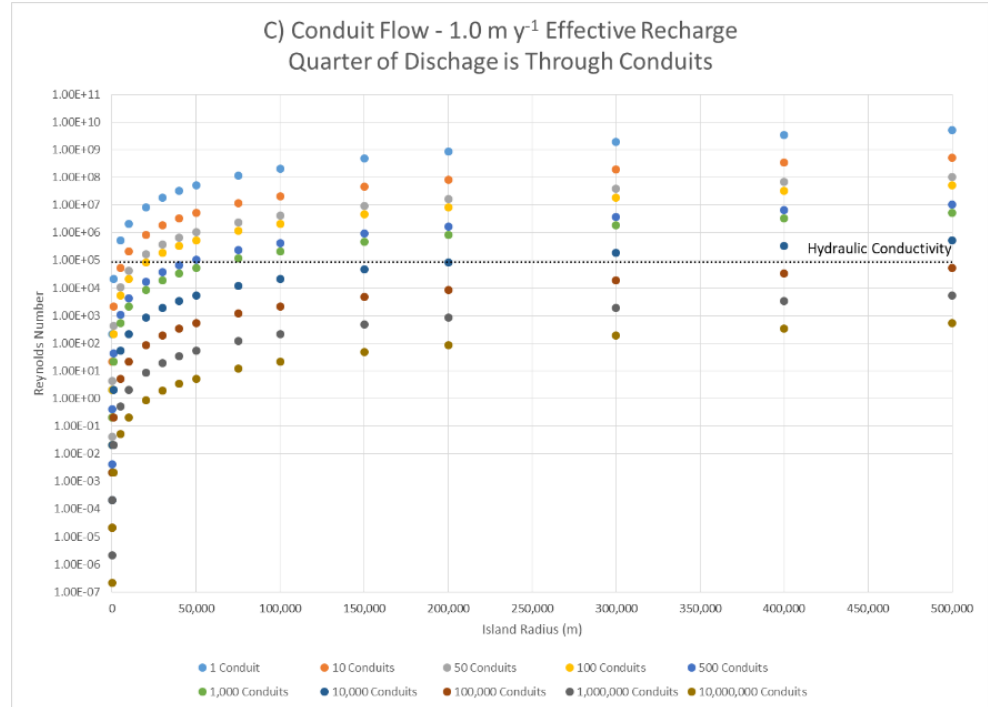
Figure 14. The effect of reducing the amount of water from draining from the aquifer through the conduits (radius = 0.75 m) as exemplified by the 1-m y −1 recharge rate (the scatter plot). ( A ) Assuming the entire amount of recharge drains through the conduits (note this is the same as Figure 13B). ( B ) Assuming that only half of the water drains through the conduits. ( C ) Assuming that only one-quarter of the water drains through the conduits. Note that as more water is diverted to diffuse flow, the Reynolds numbers are deflected closer to (or below) the hydraulic conductivity that Whitaker and Smart [28] observed (5000 m day −1 ), showing that the aquifer is able to drain more effectively. The examples shown here are more realistic in that the aquifer can and will drain through both conduit and diffuse flow, as is seen in carbonate islands that have both conduit and flank margin caves present.